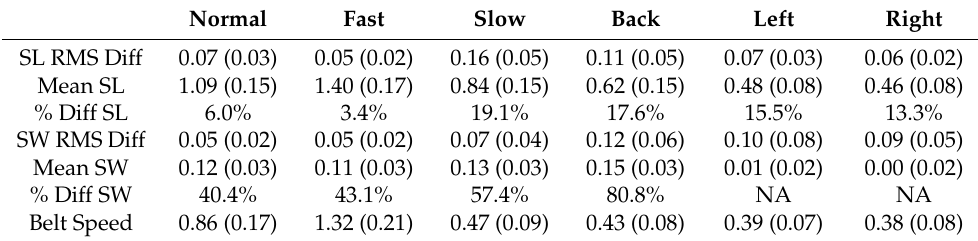
Table 6. Comparisons of stride parameters with MOCAP. Mean (standard deviation) of RMS dif- ference (IMU-MOCAP) in estimates of stride length (SL) and step width (SW). Additionally, mean (standard deviation) of the mean SL, SW, and belt speed (all estimated by MOCAP) across all subjects. Finally, mean RMS differences as percentage of the mean SL and SW (% Diff). All distances in m, speeds in m/s. Results segmented by type of walking gait; namely normal forward (Normal), fast forward (Fast), slow forward (Slow), backward (Back), lateral left (Left), and lateral right (Right). NA indicates not applicable because mean value near